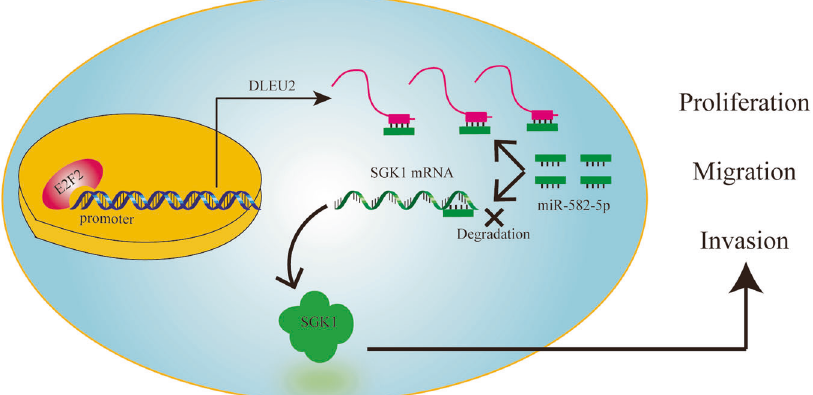
Fig. 8 A schematic diagram for the role of DLEU2 in prostate cancer progression. E2F2 induces upregulation of DLEU2 by transcriptional activation. High expression of DLEU2 facilitates prostate cancer progression by acting as a miR-582-5p sponge to modulate SGK1 expression.